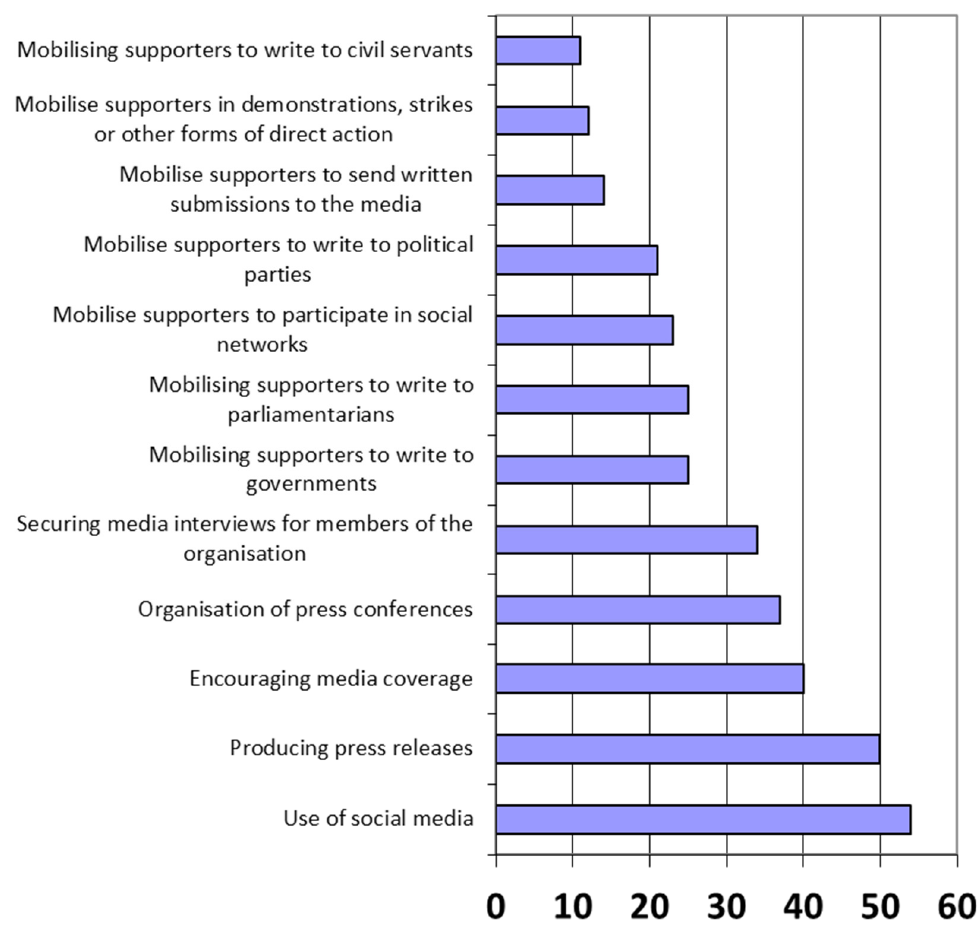
Figure 6. Distribution of the use of Grassroots lobbying actions. Source: own elaboration.